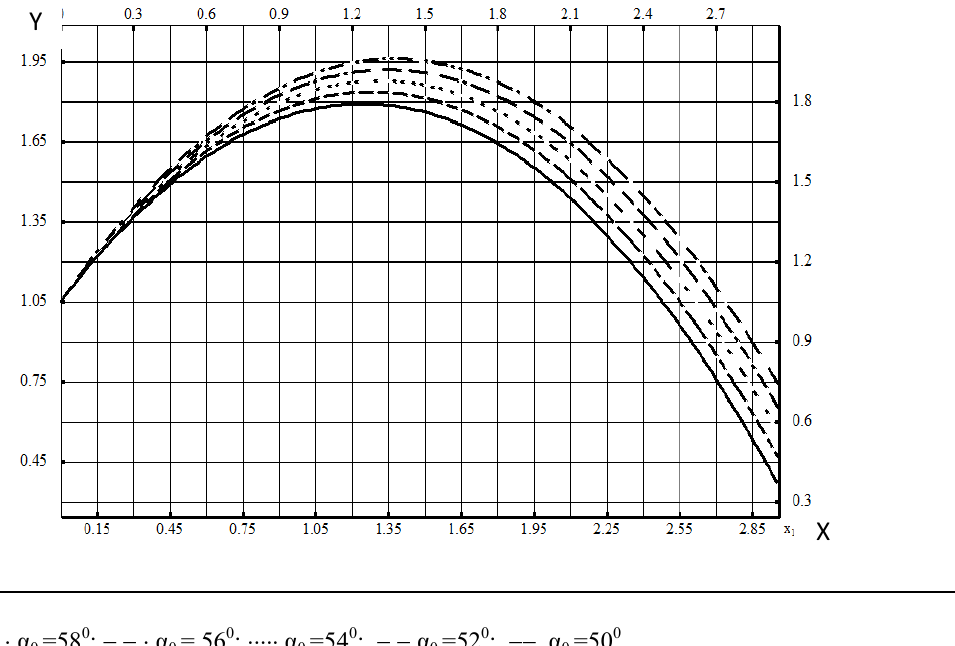
Fig.3. Characteristic curves of masses center trajectory for different values of takeoff initial speed